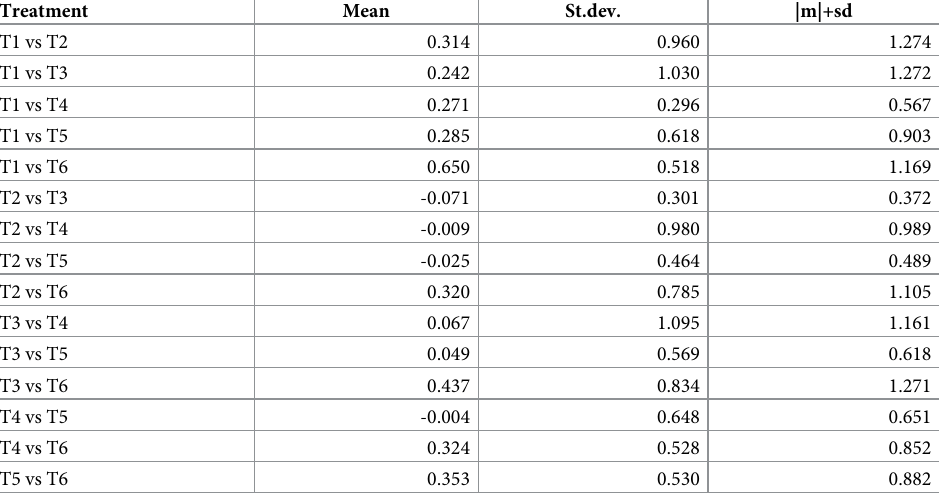
Table 4. Analysis of the temperatures measured in each treatment. Data are expressed in Celsius degree.